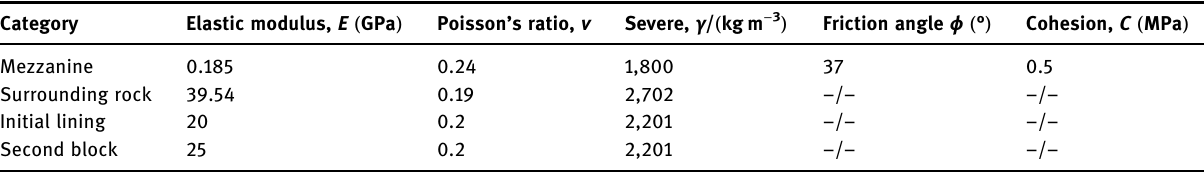
Table 1: Physical and mechanical parameters of main